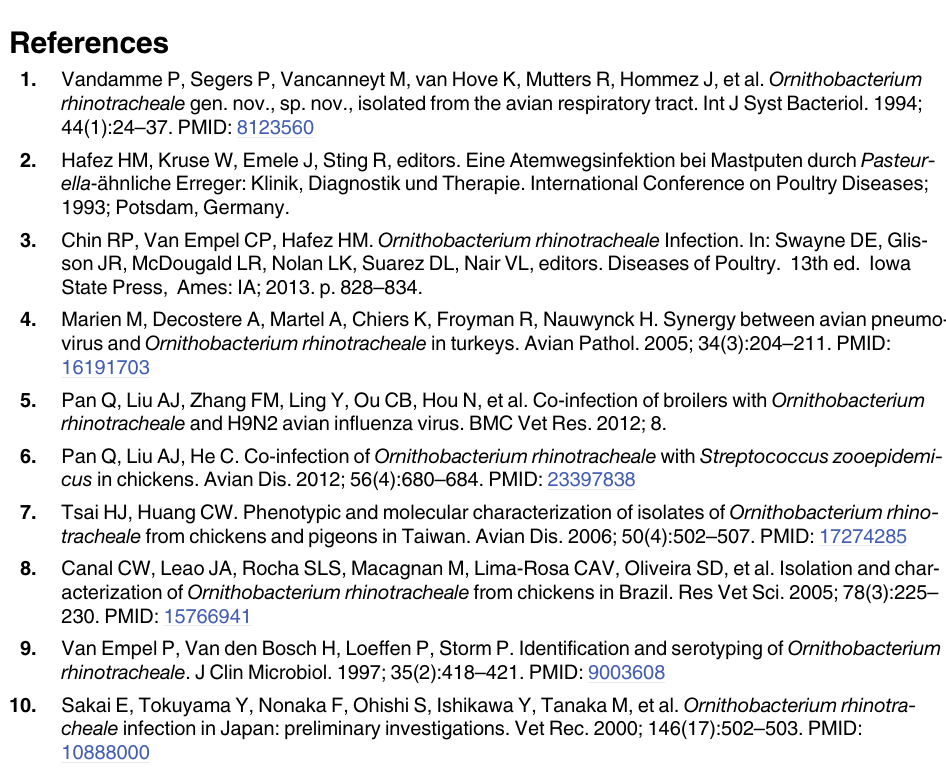
S1 Table. Details of the 87 strains used for multilocus sequence typing of Ornithobacterium rhinotracheale . RefA-RefQ: ORT strains of serotypes A to Q that have been used for produc- tion of reference antisera for serological typing of ORT field strains [9]. Slight serotype cross- reactions of ORT strains are given in parentheses. n.t.: ORT strain that could not be typed with available antisera A to L. a The serotype of the respective ORT strain was not determined, as only DNA was available for MLST